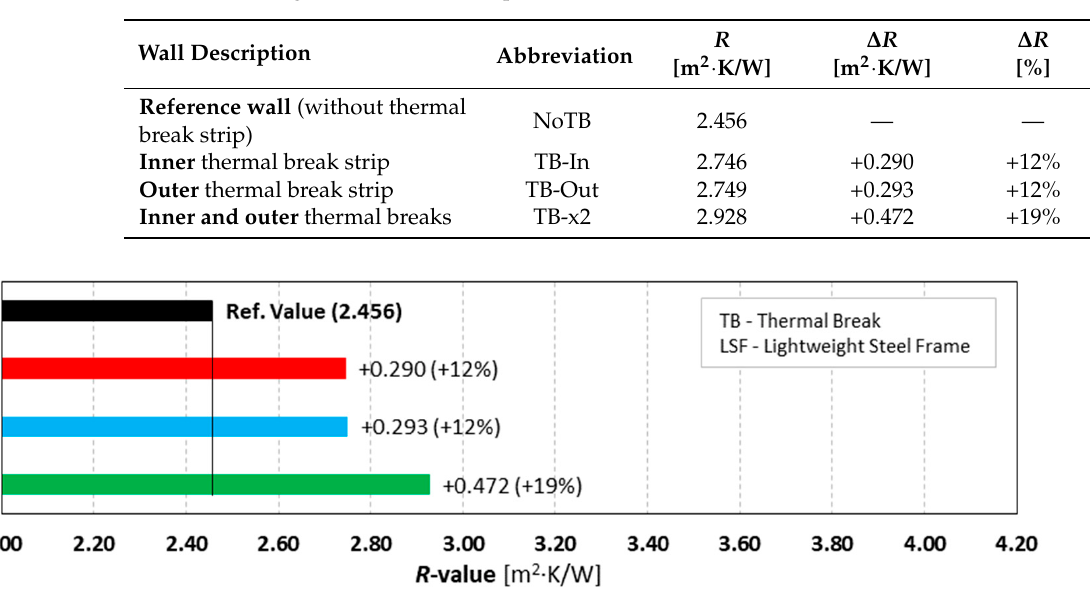
Table 4. Measured thermal resistance of double-pane LSF walls and thermal performance improvement due to aerogel thermal break strips.